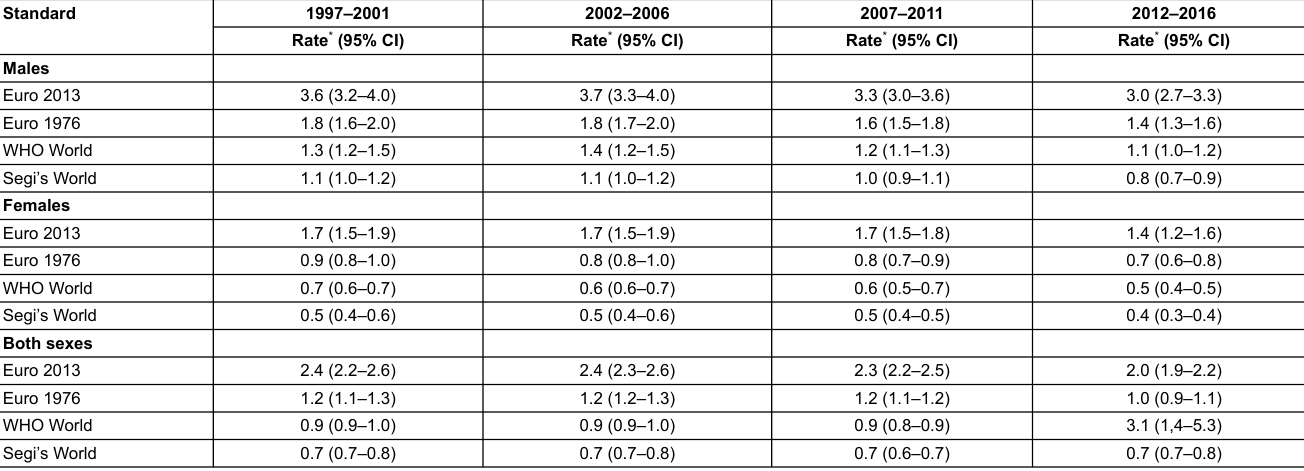
Table S4: Age-adjusted mortality of chronic lymphocytic leukaemia / small lymphocytic lymphoma in Switzerland,